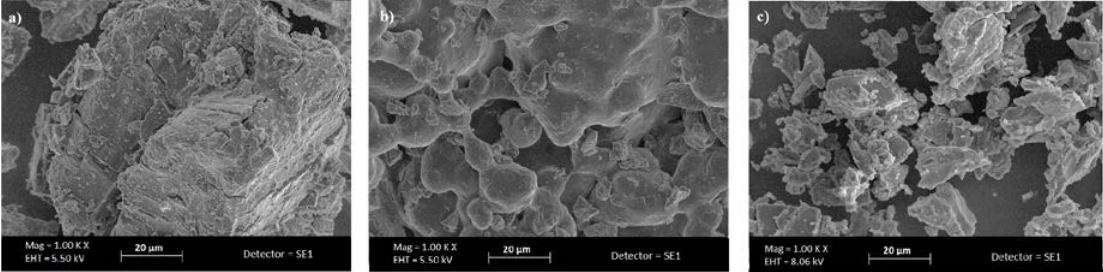
Figure 2. Scanning electron microscopy (SEM) images of ( a ) α -cyclodextrin ( b ) α -cyclodextrin polymer, and ( c ) α -cyclodextrin nanosponges (Magnification 1000 × ). The pictures underlined the different morphology of α -CD, α -CD POLY, and α -CD NS in powder